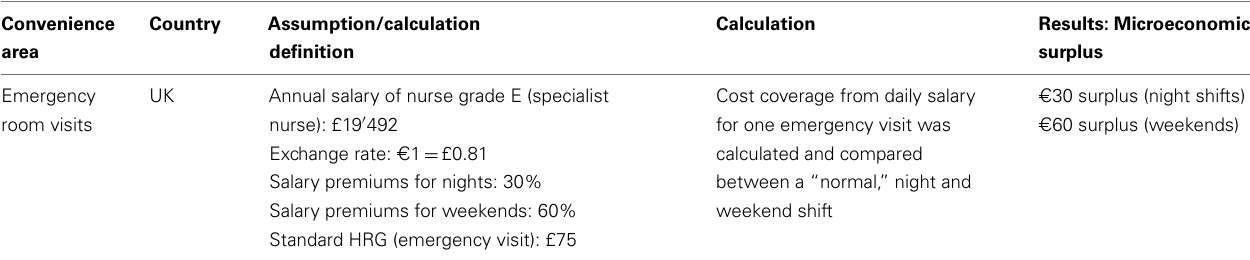
Table 2 | Summary of key assumptions in the example of emergency room visits in the UK.